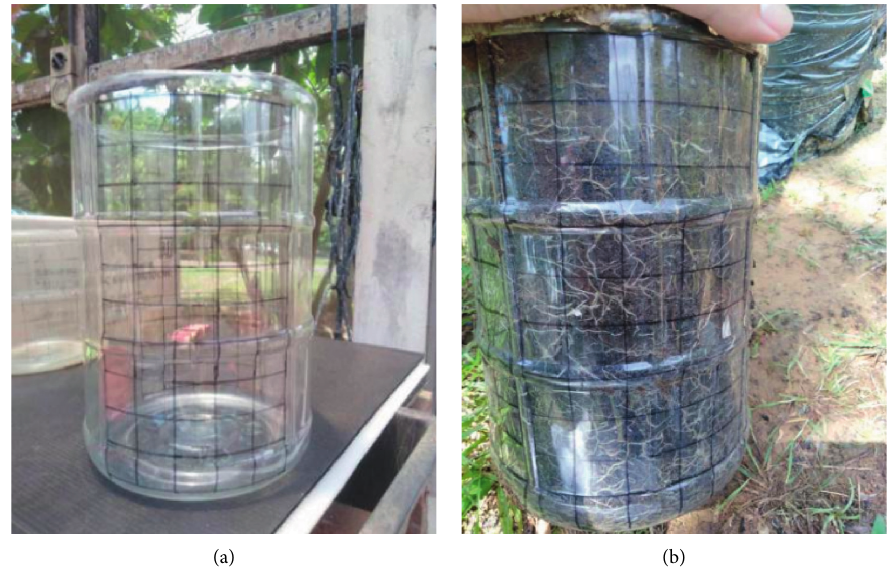
Figure 1: Drawing gridline at external pot (grid size 20 × 20mm) before the experiment (a) and root counting for root intensity (RI) (b).